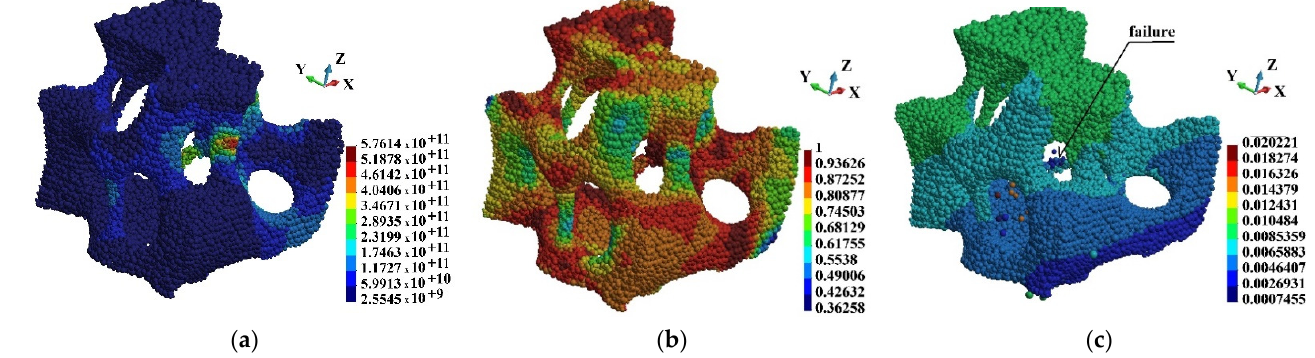
Figure 22. Region o3: ( a ) Mises stress distribution (Pa); ( b ) damage distribution; ( c ) displacements (m) in deformed configuration, scale factor 0.2.